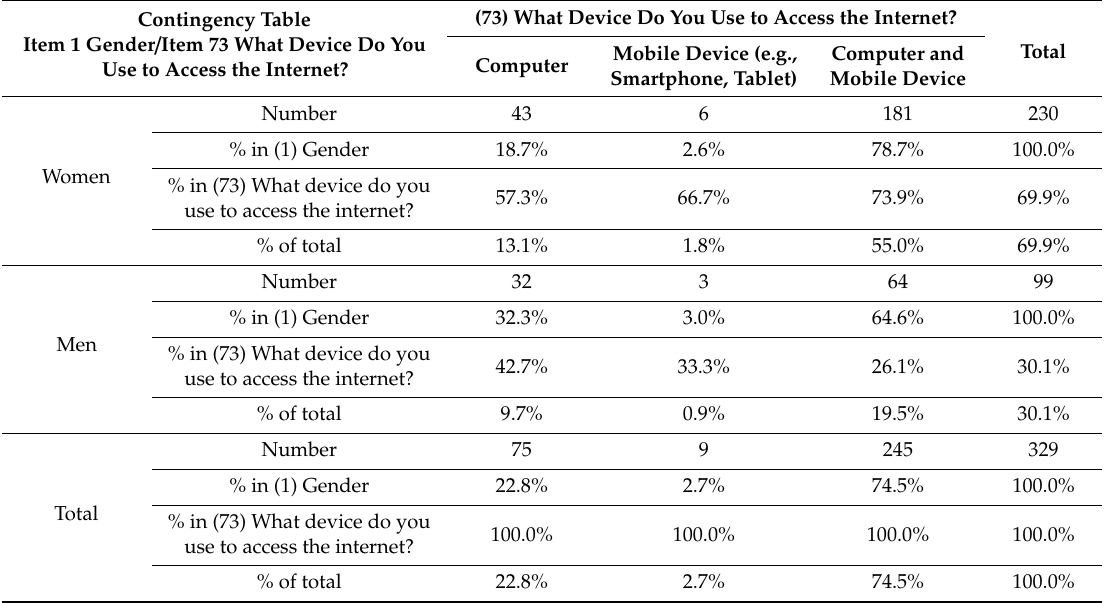
Table 2. Gender and devices. Contingency Table Item 1 Gender / Item 73 What Device Do